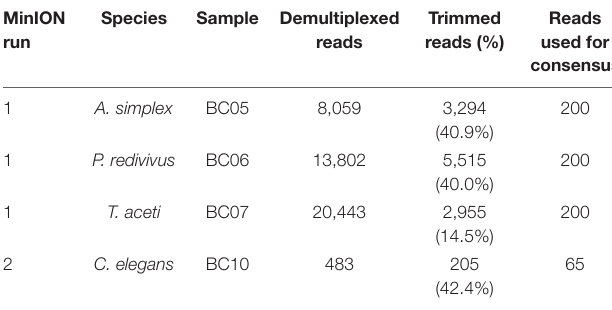
TABLE 1 | Summary of number of reads per sample in subsequent bioinformatics